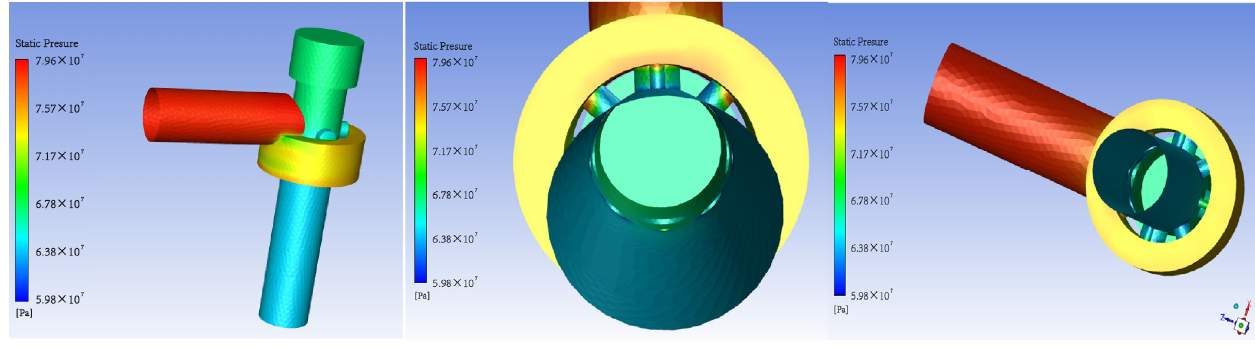
Figure 5. Pressure distribution of the choke valve.